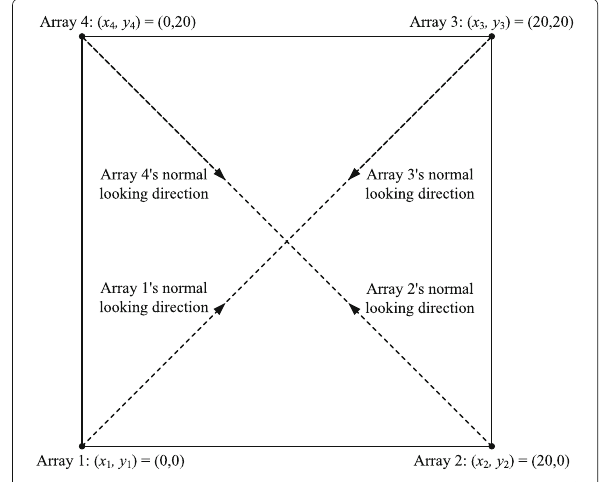
Fig. 2 Illustration of geometrical simulation assumptions. The 400-m 2 region of interest for localization and the normal looking directions of the antenna arrays of four BSs located at the corners